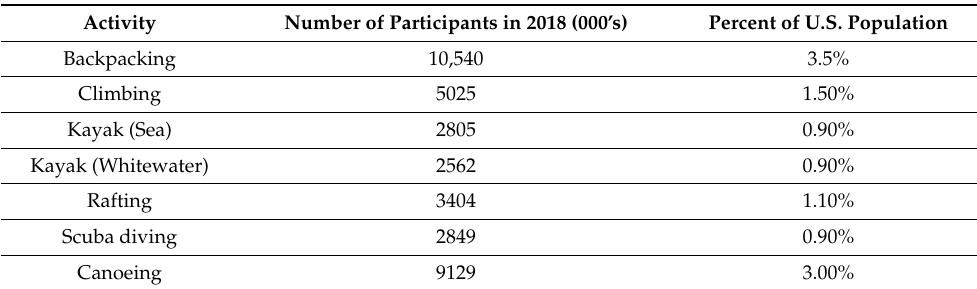
Table 1. Participation rates for selected recreational activities 1